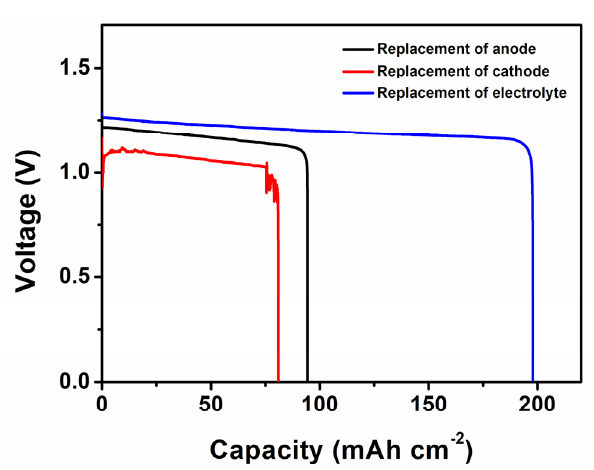
Figure 3. Discharge curves of the batteries whose cathode, anode and electrolyte were replaced, respectively, after being stored for 10 days.